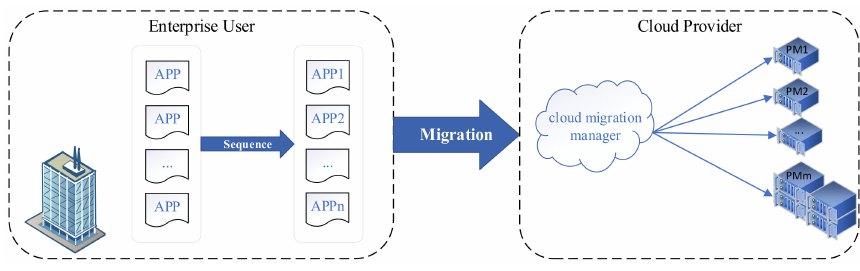
Figure 2. Basic framework of enterprise application migration to the